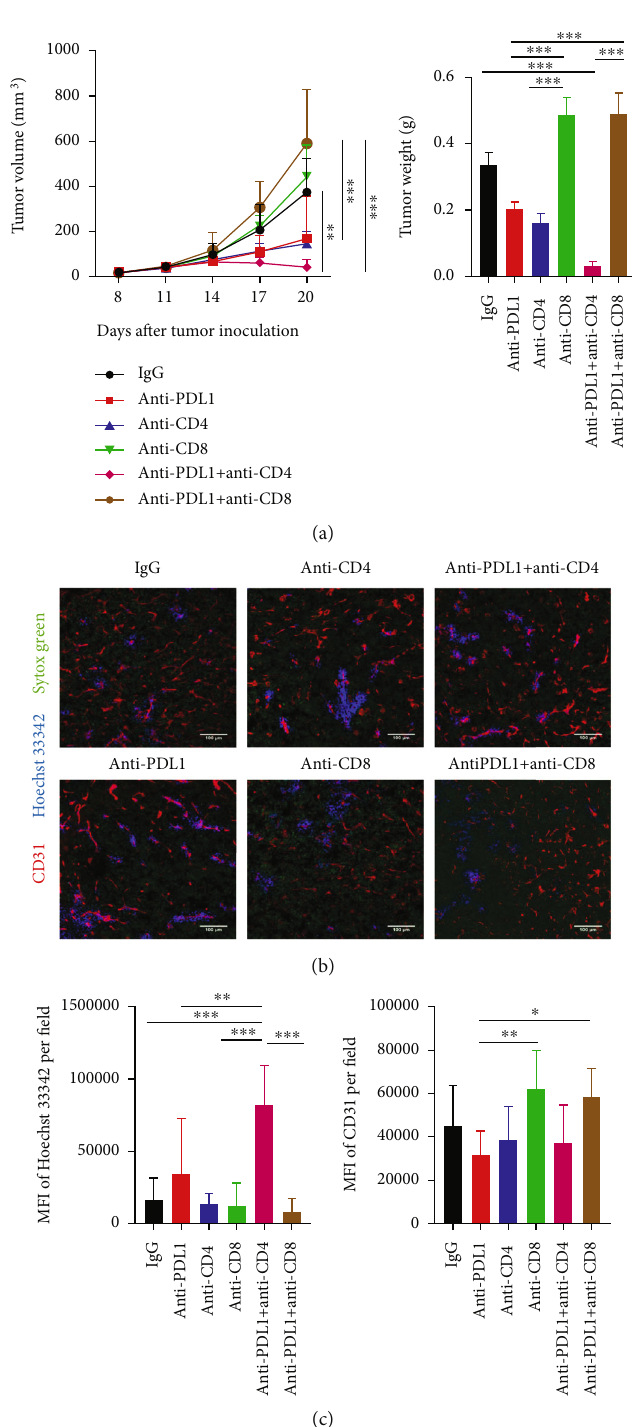
Figure 1: Simultaneous PD-L1 blockade and CD4 + T cell depletion induced vascular normalization and tumor regression in CT26 colorectal tumors. Balb/c mice were inoculated with 2 × 10 5 CT26 colon tumor cells. When tumors were grown to 4-5mm in diameter (day 0), mice were randomly assigned to 6 groups and treated with anti-CD8 and anti-CD4 antibodies on days -1, 1, and 8. On day 0, mice were treated with anti-PD-L1 (10mg/kg) or IgG (10mg/kg) antibody, every 3 days for 4 doses. On day 12 post anti-PD-L1 treatments, mice were injected with 200 μ g/mouse Hoechst 33342 via the tail vein. Five minutes later, tumors were harvested for immunohistochemistry staining. (a) Tumor growth curves and tumor weight. (b) Representative fi gures showed CD31 + tumor blood vessels (red) and Hoechst 33342 stained, functional blood vessels (blue) in CT26 tumor tissues. (c) Total tumor blood vessel density and Hoechst 33342 perfused area were quanti fi ed. Scale bars: 100 μ m. Signi fi cant di ff erences were determined by one-way ANOVA. Data were from one experiment representative of two independent experiments with similar results ( n = 7 − 8 mice per group). Data were shown as means ± SD . ∗ P < 0 : 05 , ∗∗ P < 0 : 01 , ∗∗∗ P < 0 : 001